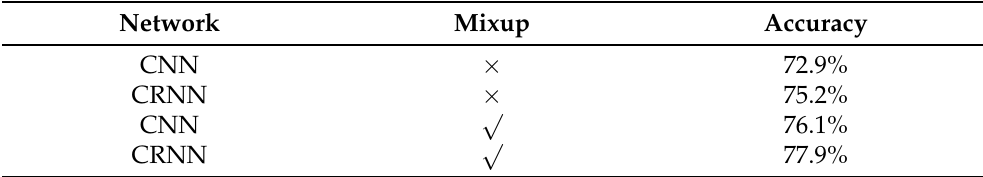
Table 3. Classification accuracy of whether to use CRNN or mixup.